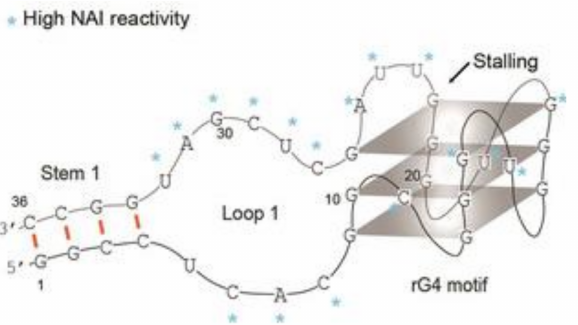
Figure 8. The proposed structure of Ap3-7 [79]. Reproduced with permission from John Wiley and Sons, © 2020 Wiley-VCH Verlag GmbH & Co. KGaA, Weinheim.